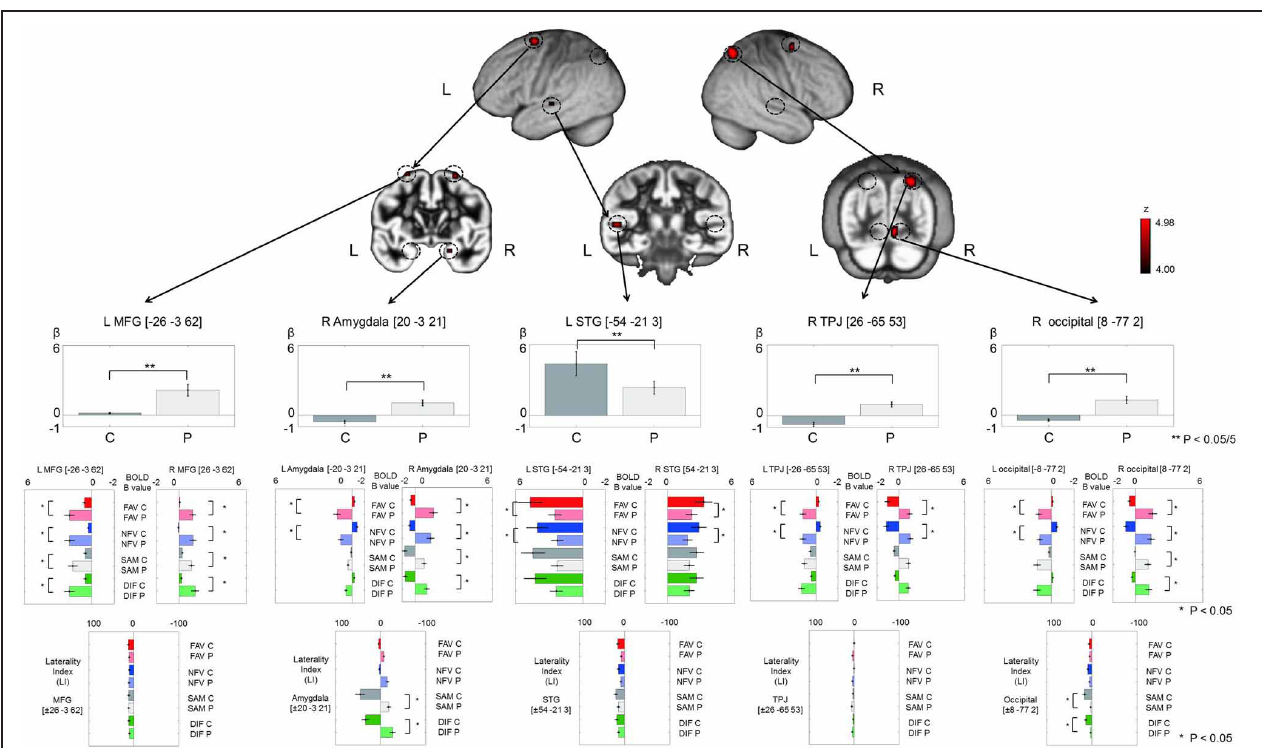
middle row represent the distribution of beta values (mean ± SE) on 5 ROIs and contralateral symmetrical 5 ROIs under FAV (red), NFV (blue), SAM (gray), and DIF (green) conditions—C, controls (dark gray); P, patients (light gray). Color bars at the bottom represent the distribution of laterality index (mean ± SE) on the 5 ROIs. ∗ Indicates p < 0 . 05. MFG, middle frontal gyrus; STG, superior temporal gyrus; TPJ, temporo-parietal junction; occipital, occipital lobe.